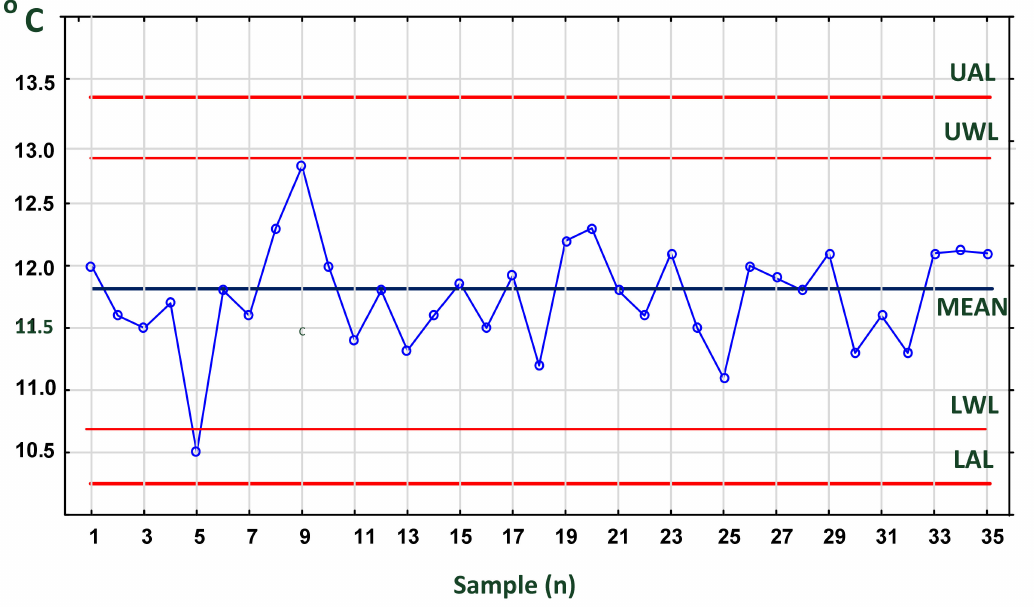
Figure 8. Mean control chart for temperature samples measured in a container at 2 h intervals. Source: own data. Abbreviations: UAL—upper action line, UWL—upper warning line, LWL—lower warning line, LAL—lower action